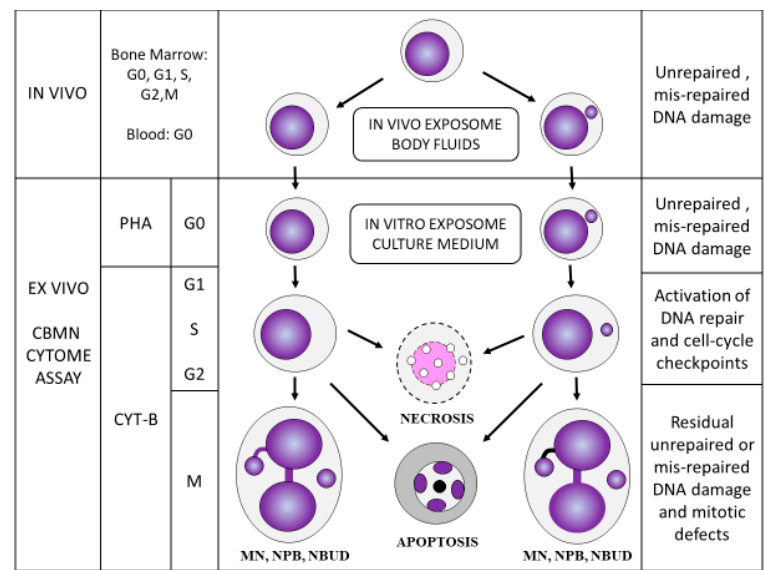
Figure 3. The main features of the lymphocyte cytokinesis-block micronucleus cytome (CBMNcyt) assay. G0, G1, S, G2, and M represent the various stages of the nuclear division cycle following stimulation using the mitogen phytohaemagglutinin (PHA). CYT-B, cytochalasin-B, which is used to block cells that complete nuclear division at the binucleated stage. MN, micronucleus; NPB, nucleoplasmic bridge; NBUD, nuclear bud. This figure is a copy of Figure 3 in Kirsch-Volders et al. [37]. Permission to re-use this figure was obtained from the publisher Elsevier.